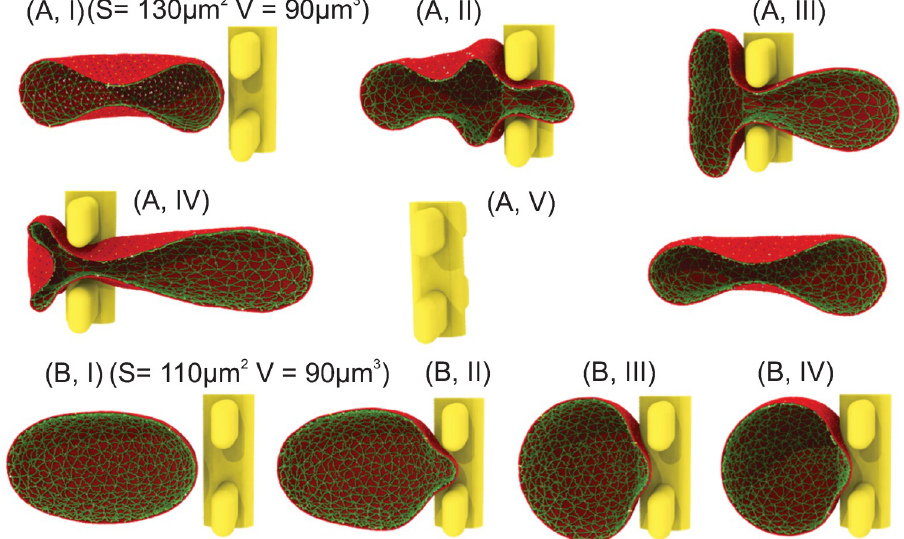
Fig 4. (A) Five successive snapshots of a normal RBC with surface area of 130 μ m 2 and cell volume of 90 μ m 3 passing through IES driven by a pressure gradient of 5 Pa μ m − 1 . (B) Four successive snapshots of an RBC with surface area of 110 μ m 2 and cell volume of 90 μ m 3 moving toward IES and being retained at IES at a pressure gradient of 8 Pa μ m − 1 . Only one half of the RBC is shown for